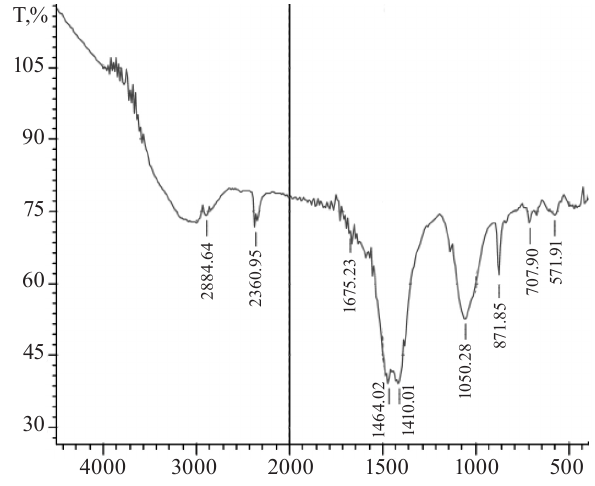
Figure 10 Infrared spectra of activated charcoal after adsorption of crystal violet